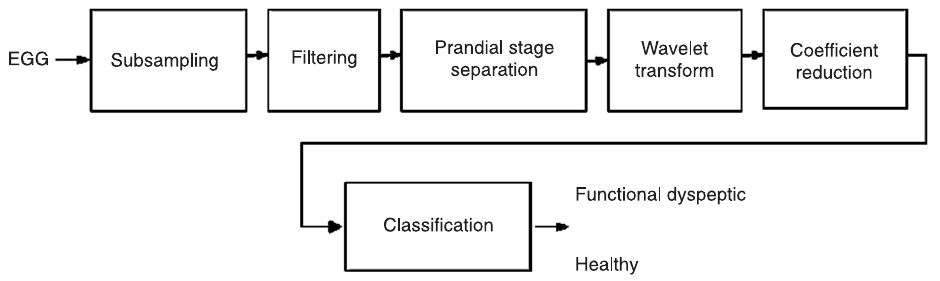
Figure 1. Preprocessing and classification steps: at the input the electrogastrograms (EGG) and at the output the classes: healthy or functional